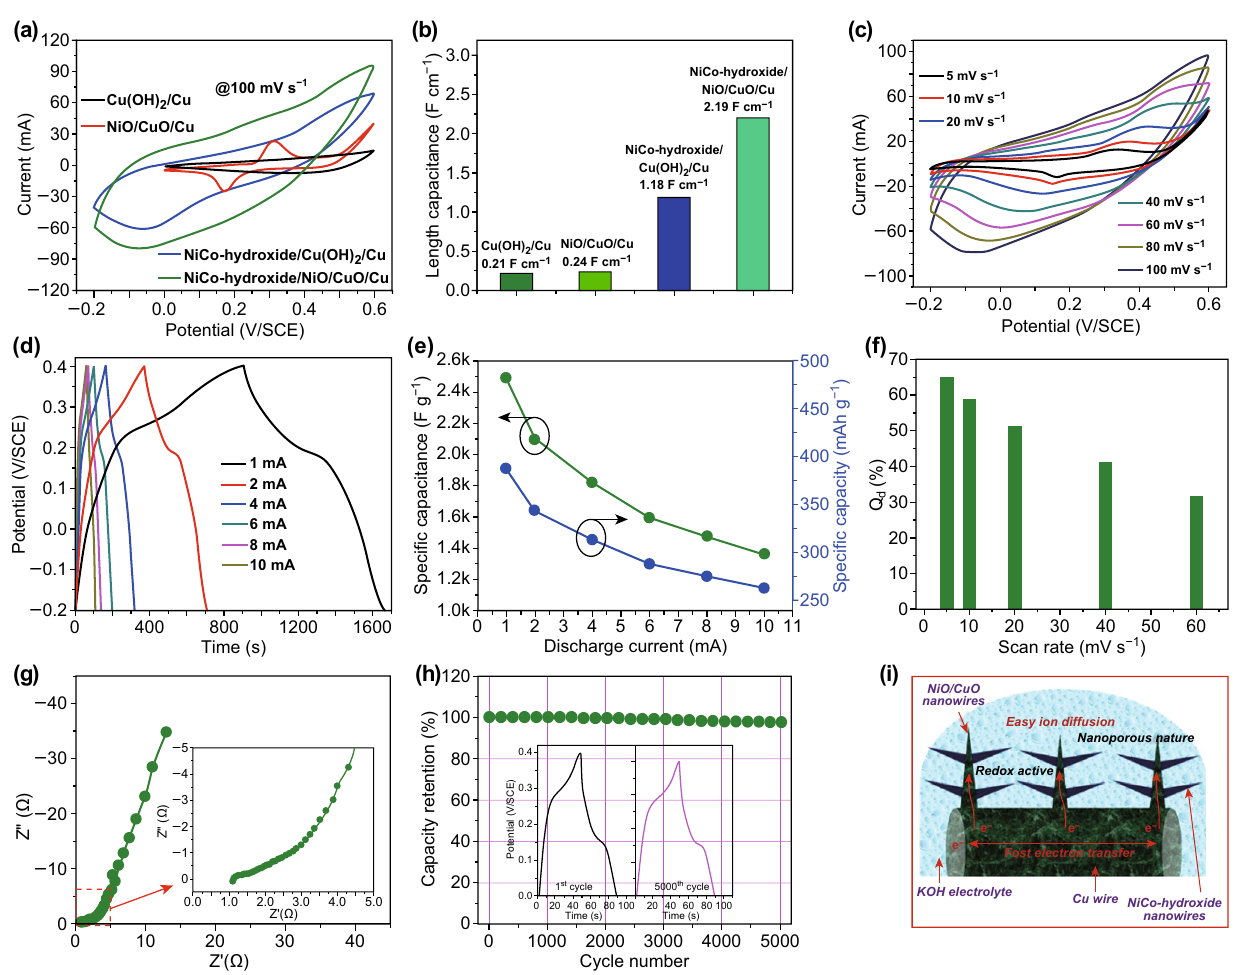
Fig. 3 a Comparative CV curves and b corresponding length capacitance for the Cu(OH) 2 /Cu, NiO/CuO/Cu, NiCo‑hydroxide/Cu(OH) 2 /Cu and NiCo‑hydroxide/NiO/CuO/Cu electrodes at a constant scan rate of 100 mV s −1 . c CV and d CD curves for the NiCo‑hydroxide/NiO/CuO/Cu electrode at various scanning rates in 2 M KOH electrolyte. e specific capacitance and specific capacity for the NiCo‑hydroxide/NiO/CuO/Cu electrode at various currents. f Plot of diffusion‑controlled contribution at different scan rates for the NiCo‑hydroxide/NiO/CuO/Cu electrode. g Nyquist plot for the NiCo‑hydroxide/NiO/CuO/Cu electrode. The inset shows the magnified view of the Nyquist plot. h Plot of capacity retention versus cycle number for the NiCo‑hydroxide/NiO/CuO/Cu electrode. The inset shows the first and last cycles. i Schematic representation show‑ ing the merits of the NiCo‑hydroxide/NiO/CuO/Cu electrode for the RAB